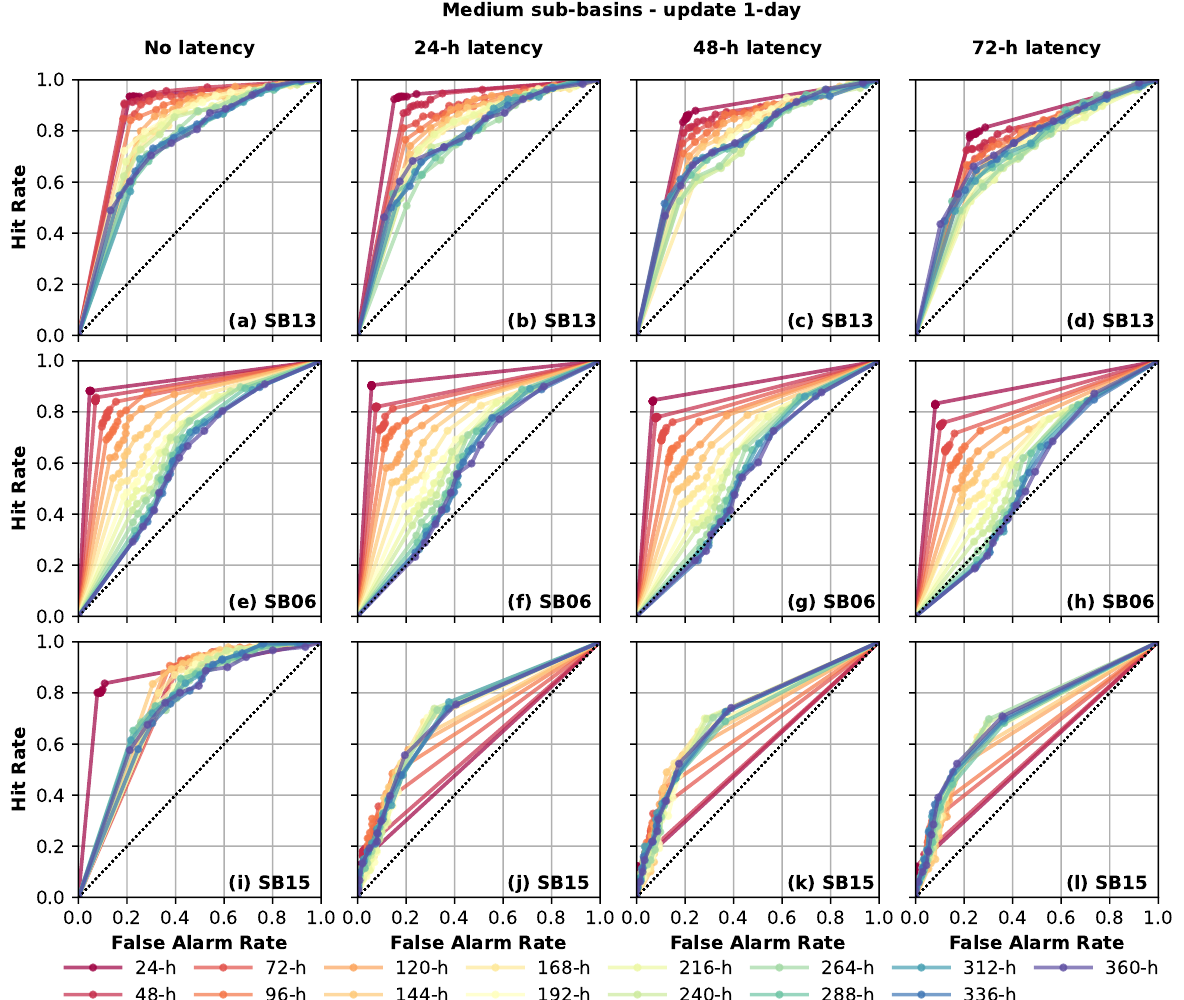
Figure 9. ROC diagrams of the probabilistic streamflow forecast for medium sub-basins. MHD-INPE 1 d update for: no latency (left column), 24 h latency (center-left column), 48 h latency (center-right column), and 72 h latency (right column), for streamflow with a probability level of